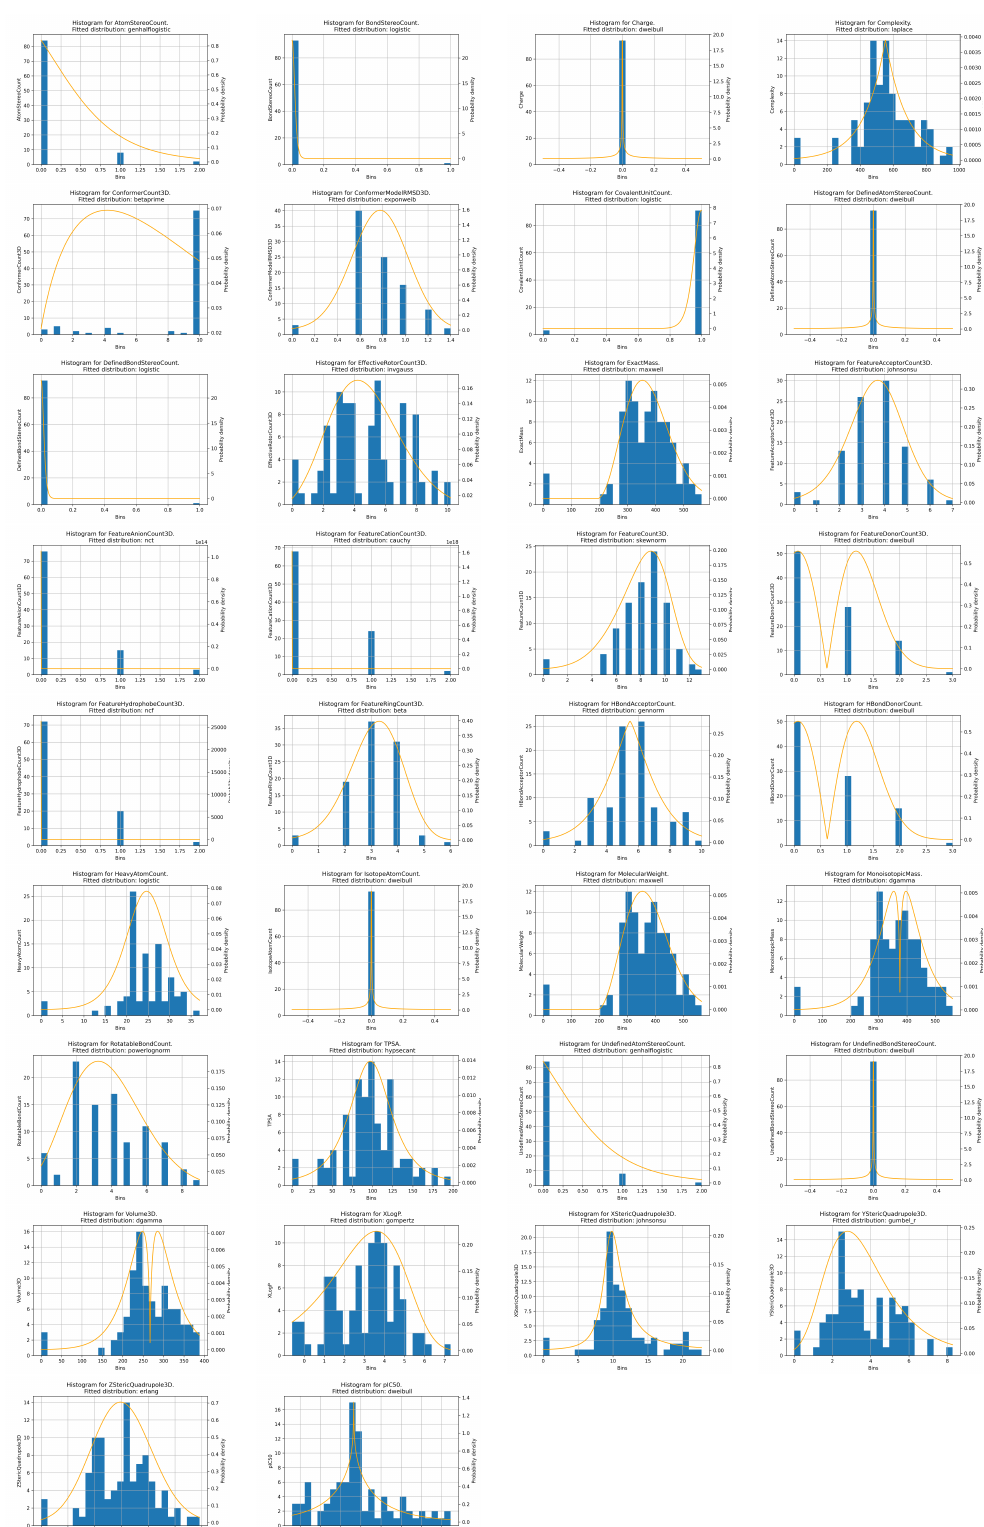
Figure A1. The distributions of the input